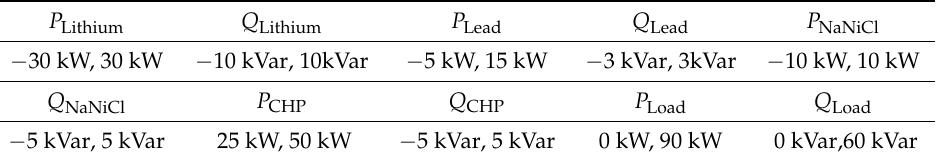
Table 1. Upper and lower limits of the control devices.